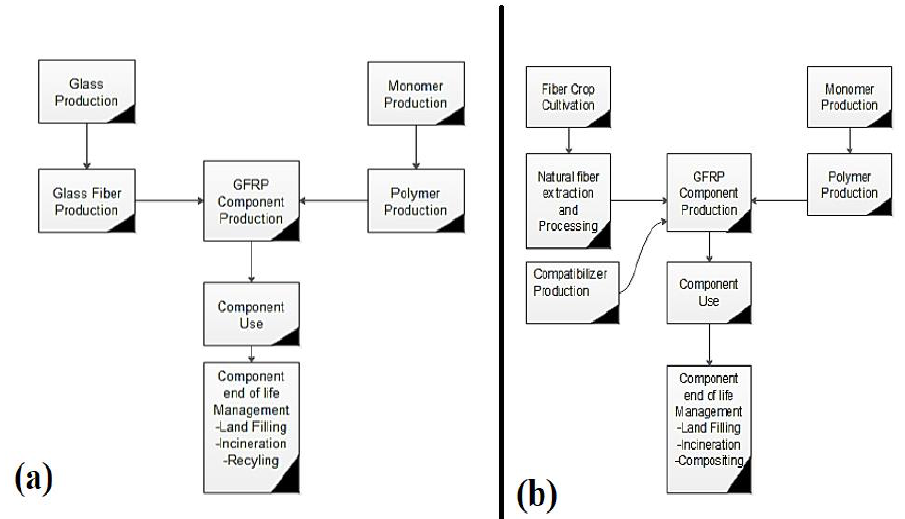
Figure 2. ( a ) Life cycle stages of glass fibre-reinforced polymer (GFRP) composite, and ( b ) Life cycle stages of natural fibre-reinforced polymer composite component. Adapted with permission from Reference [20]. Copyright 2004, with permission from Elsevier.